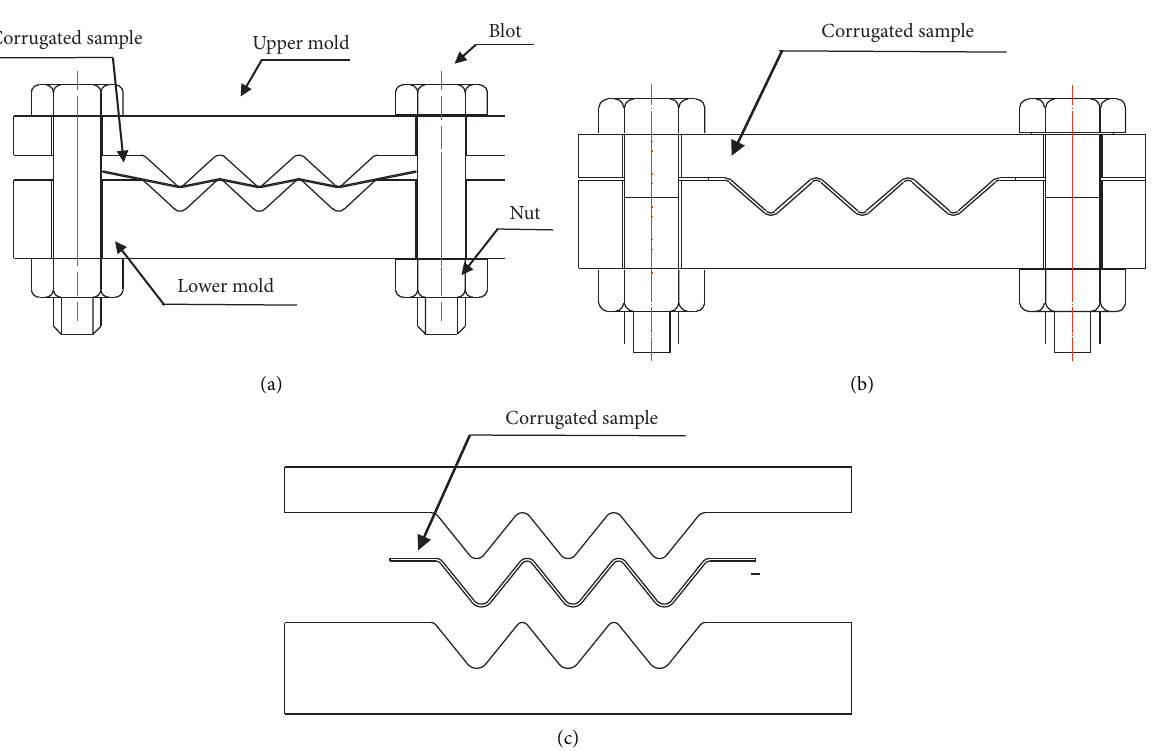
Figure 3: Flowchart of sample preparation. (a) Clamped at room temperature (25 ° C). (b) Shaped at high temperature (500 ° C). (c) Released at room temperature (25 ° C).